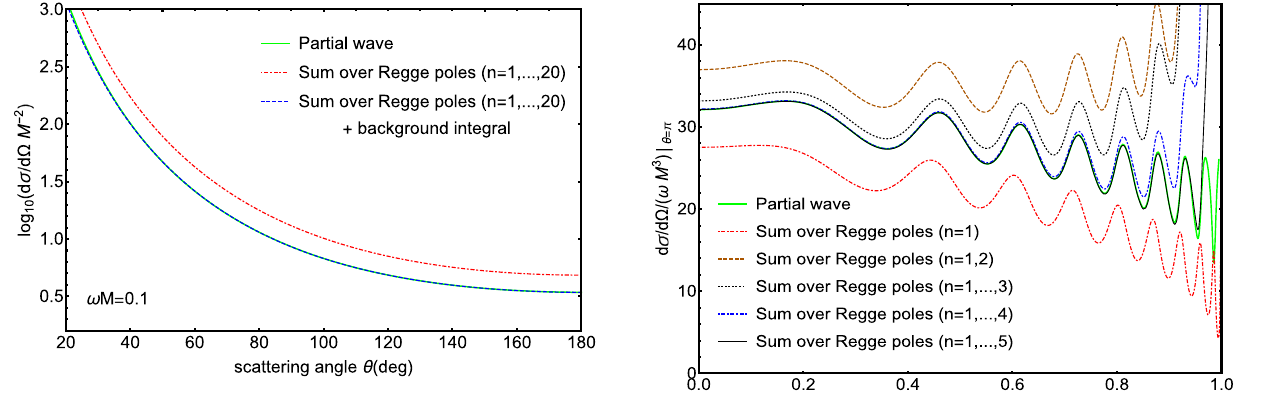
backscattered wave. With only 4 Regge poles, the